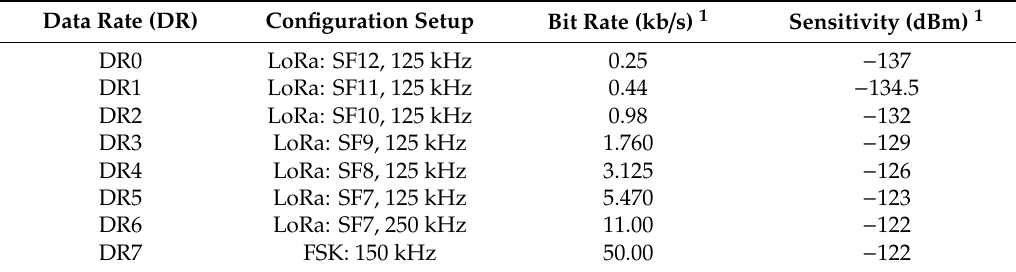
Table 1. Peak physical layer data rate for SFs and BW used by LoRaWAN in EU868 MHz ISM band. Data Rate